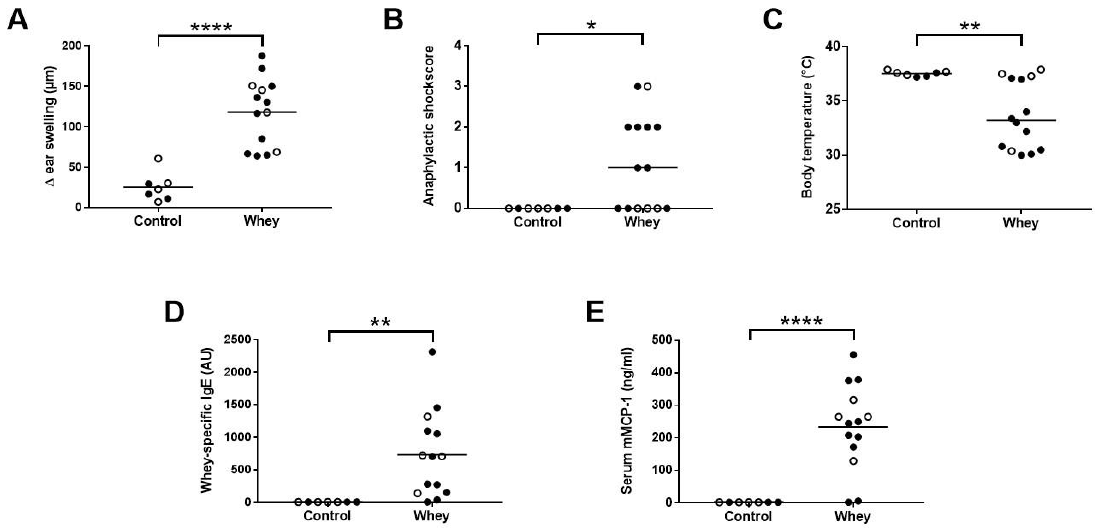
Figure 2. Acute allergic symptoms upon whey protein challenge in a cow’s milk allergy model. ( A )